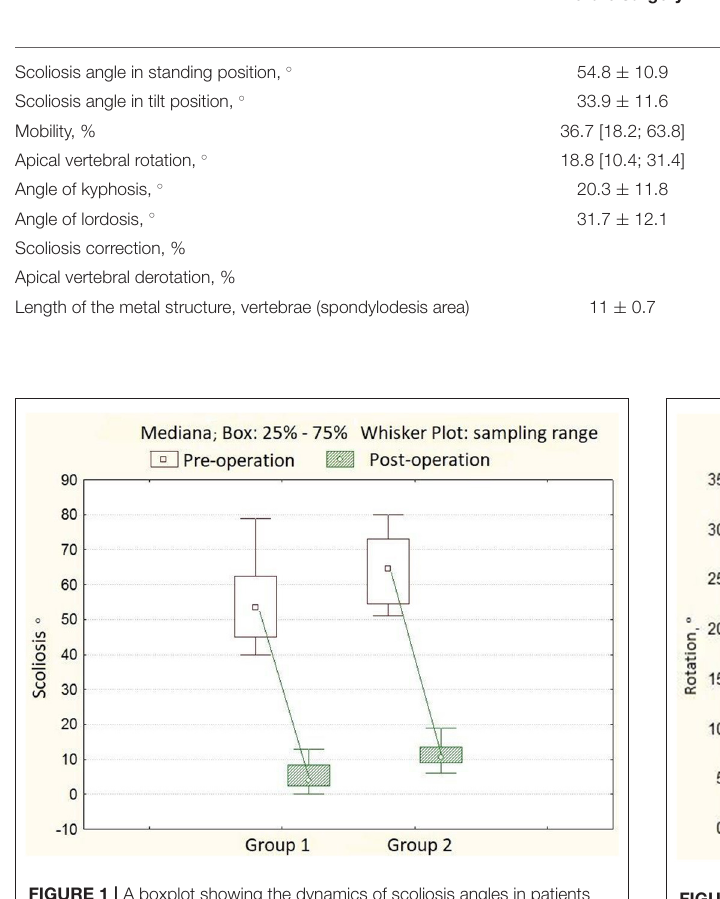
TABLE 1 | The main descriptive statistics for the indicators of the first group, n = 20. Before surgery After surgery One year Three years